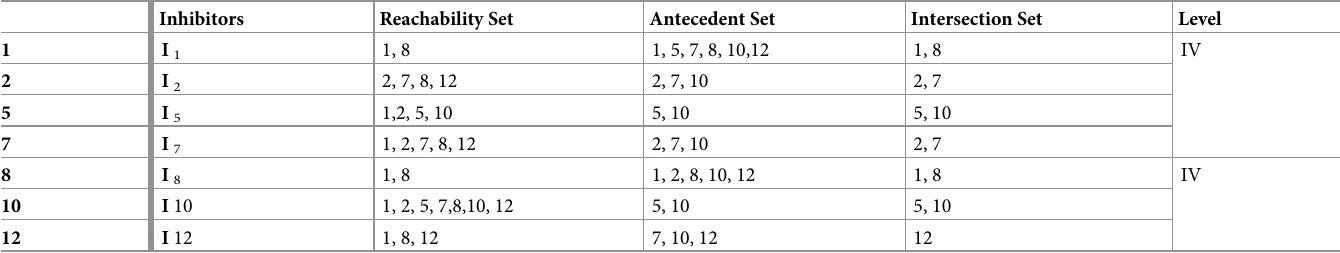
Table 10. Level partitioning iteration-4.